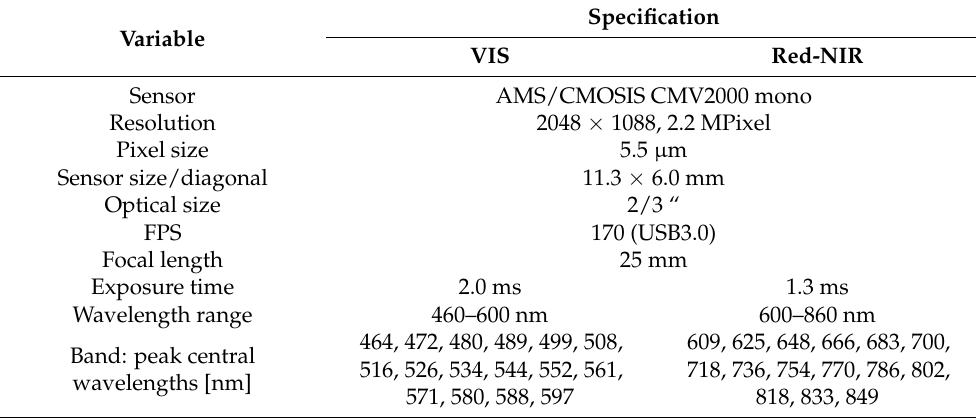
Table 2. The hyperspectral camera specification.